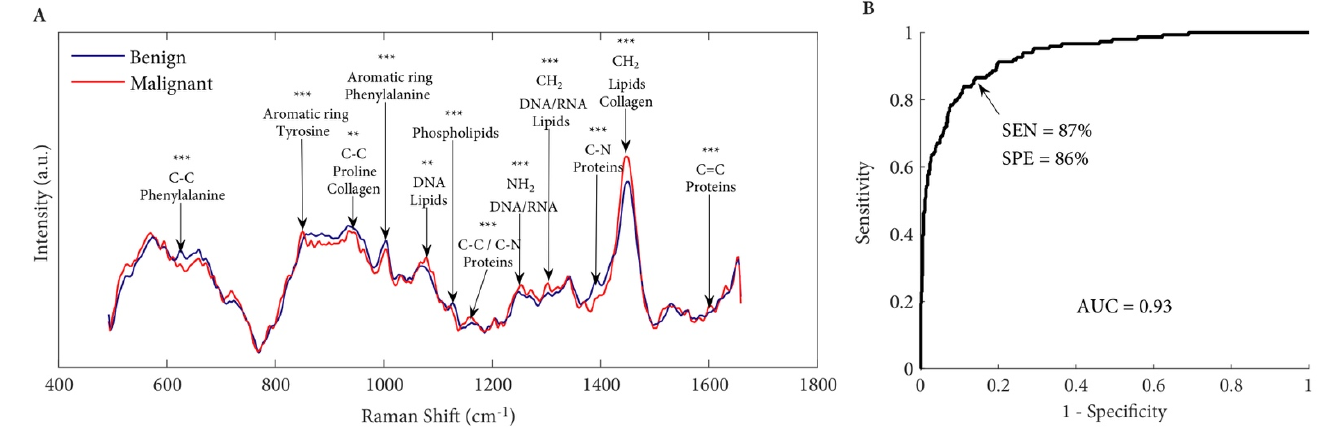
Figure 6. ( A ) Average Raman spectra for benign ( n = 776) and malignant ( n = 149) tissues. Corre- sponding peaks are shown with black arrows. ( B ) Receiver operating characteristic (ROC) curve distinguishing benign from malignant tissue with an accuracy of 86%. SEN, sensitivity; SPE, speci- ficity; AUC, area under the curve. Univariate analysis performed on Raman peaks are illustrated with p values: *** p < 0.001, ** p < 0.01. Images reproduced from [36] with permission from Wiley (copyright 2018).